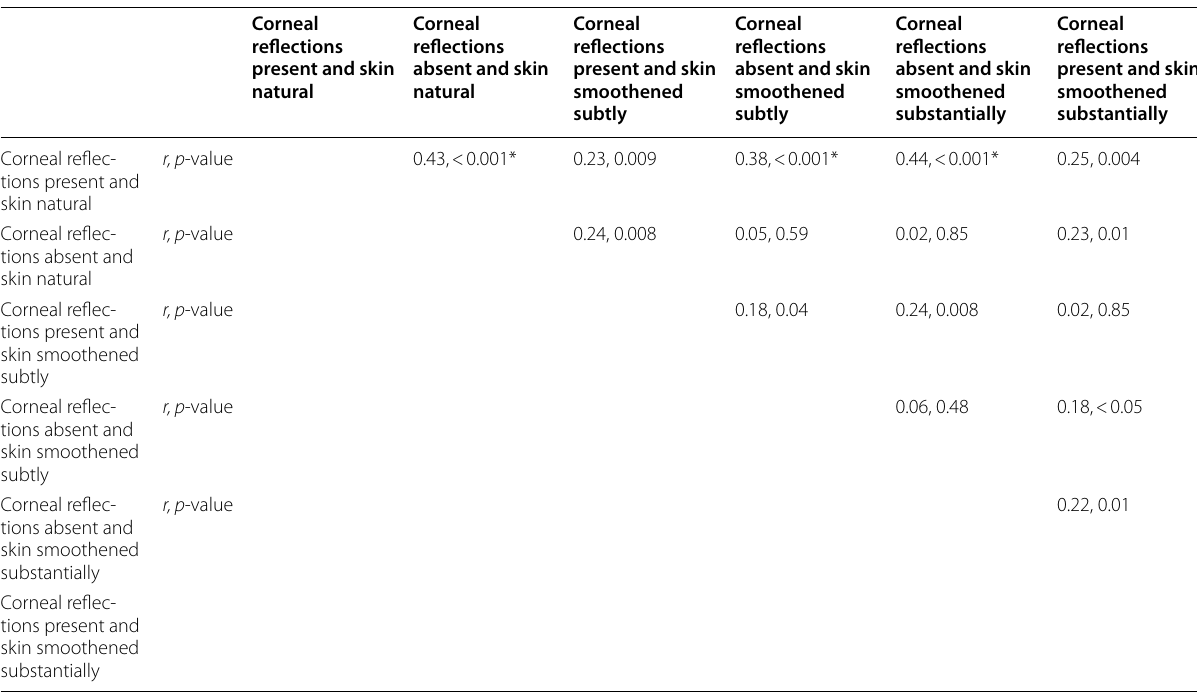
Table 2 All binary comparisons of d ′ values between different conditions with the associated effect size